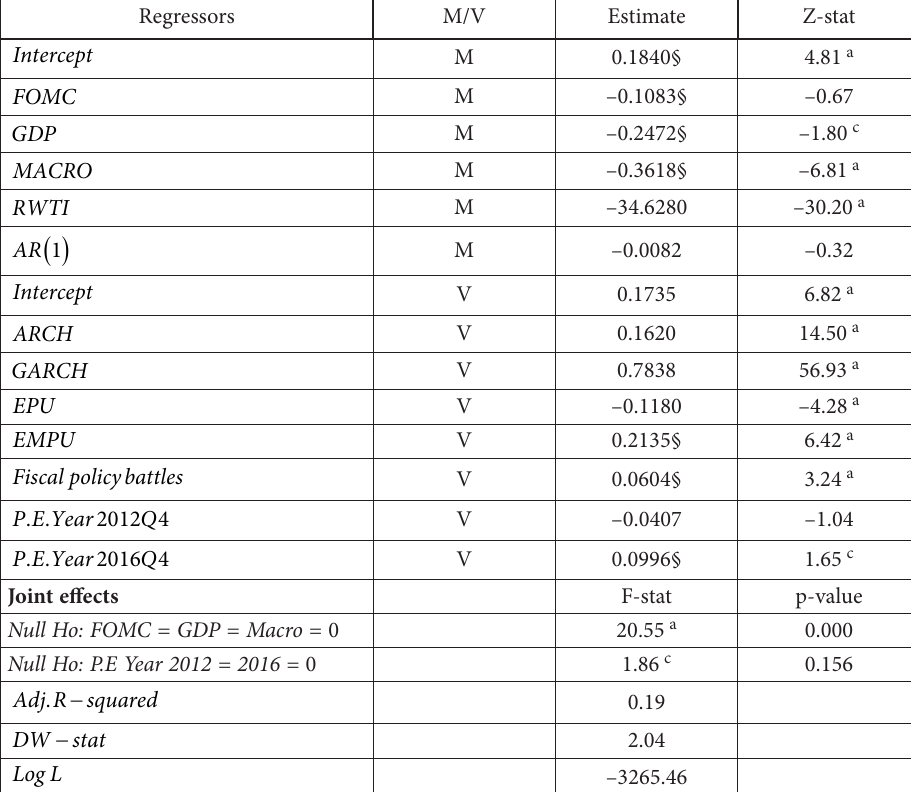
Table 9. Economic policy uncertainty and WTI oil volatility index (OIV)